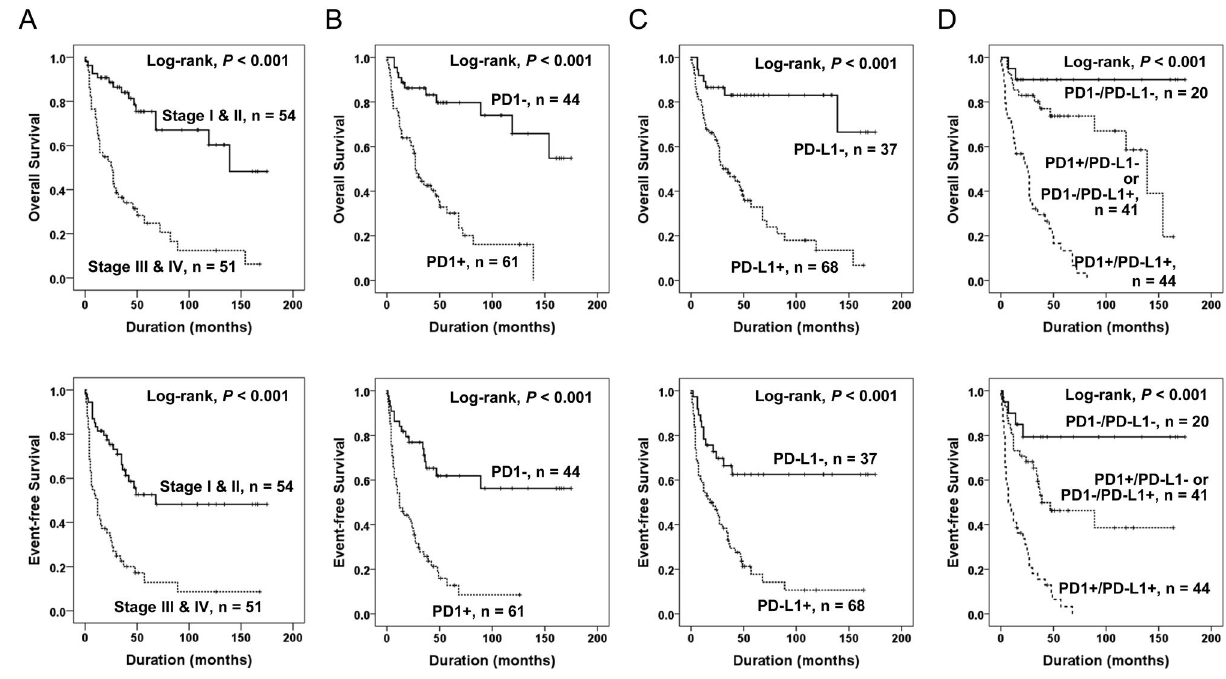
Figure 2. Kaplan-Meier survival analysis in soft-tissue sarcomas. Overall survival and event-free survival according to tumor stage (A), intra-tumoral infiltration of PD1-positive lymphocytes (B), expression of PD-L1 (C), and the combined expression pattern of PD1 and PD-L1 (PD1/PD-L1) (D).